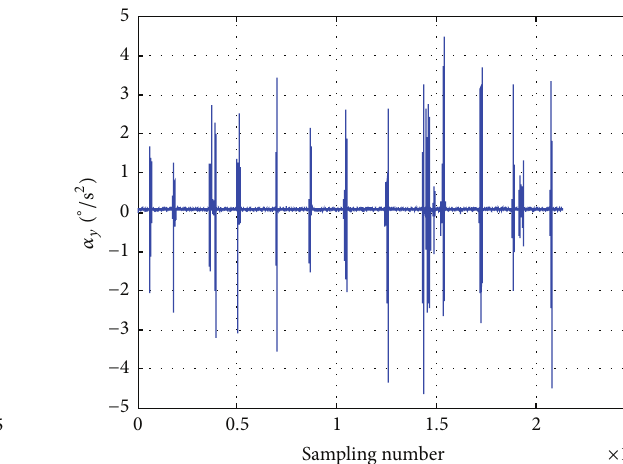
Figure 12: 𝜃 𝑧 for uncontrolled system.